Question: In a single sentence, describe what this figure presents.
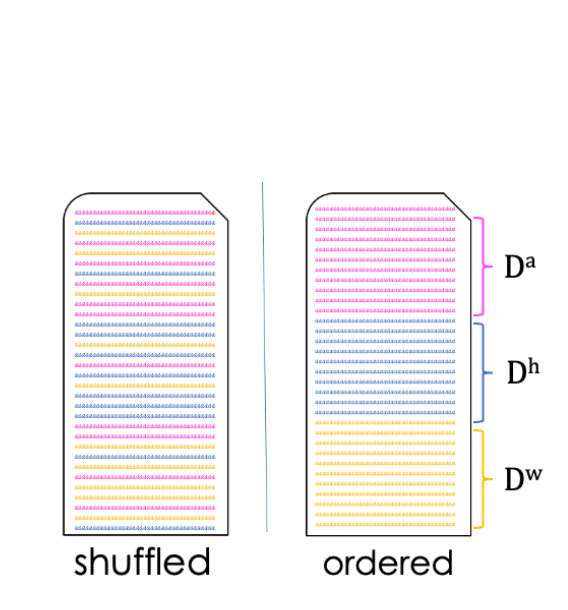
Answer: Illustration showing shuffled vs. ordered input for multi-document summarization consisting of documents from three diverse groups (Da, Dh, Dw) as indicated by the three colors. The ordered input is denoted as Oa when Da documents appear first in the input.